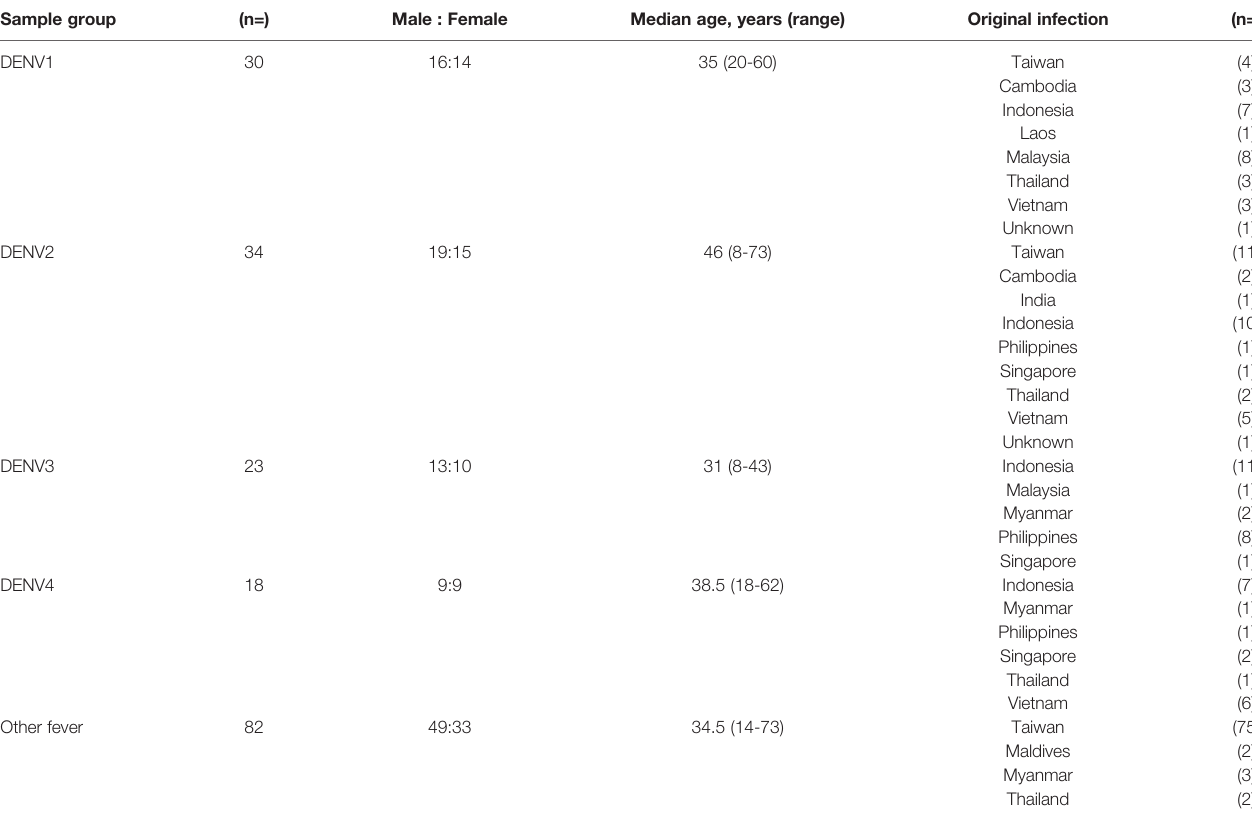
TABLE 5-1 | Summary of clinical serum samples in this study. Sample